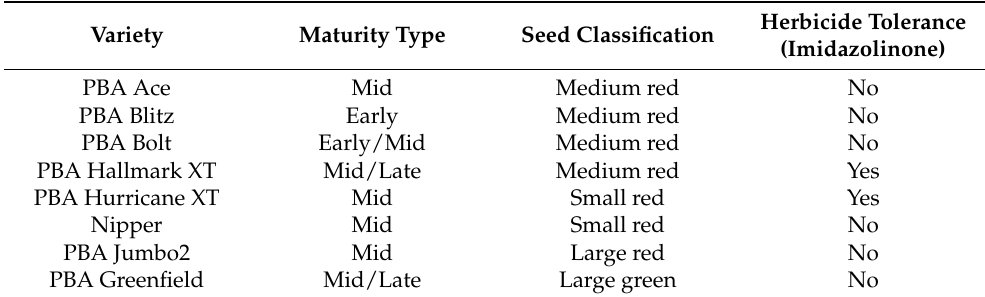
Table 1. Lentil genotypes and their classification/characteristics evaluated in the 2018 and 2019